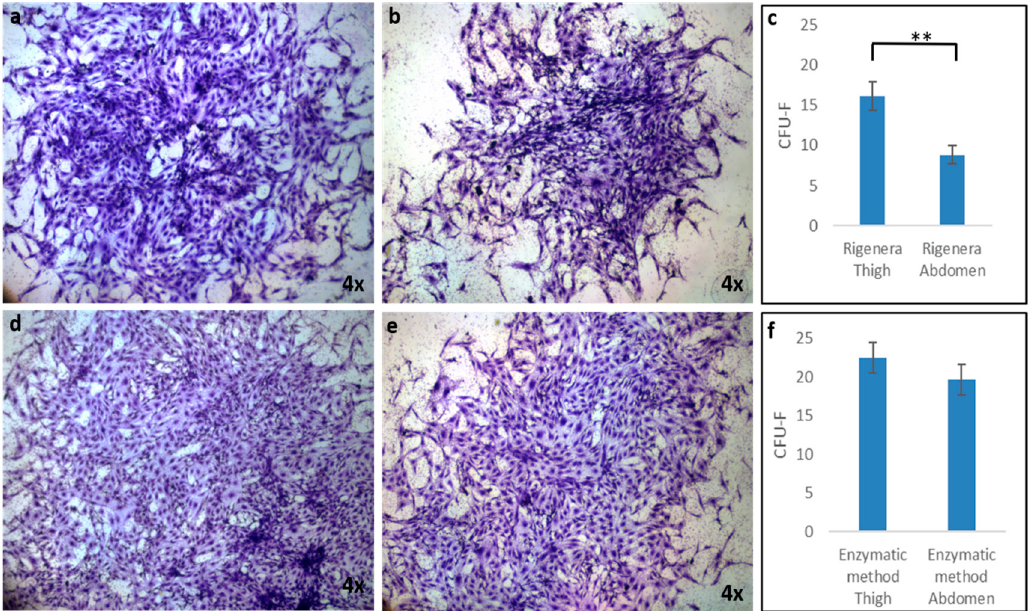
Figure 4. The colony-forming unit-fibroblast (CFU-F) assay of ASCs obtained by Rigenera ® (( a ) thigh and ( b ) abdomen) and the enzymatic method (( d ) thigh and ( e ) abdomen). CFU-F values were determined at day 15 after plating using the Toluidine Blue staining method. ASCs extracted from the thigh ( a – d ) formed larger colonies containing more cells than those extracted from the abdomen ( b – e ); ( c ) CFU-F numbers at day 15 obtained by the Rigenera ® device; CFU-F numbers showed significant di ff erences between the two groups (thigh and abdomen). ( f ) CFU-F numbers at day 15 obtained by the enzymatic method; CFU-F numbers showed no significant di ff erences between the two groups (thigh and abdomen). Data are presented as the mean ± SE, with n = 6 (** p < 0.01).